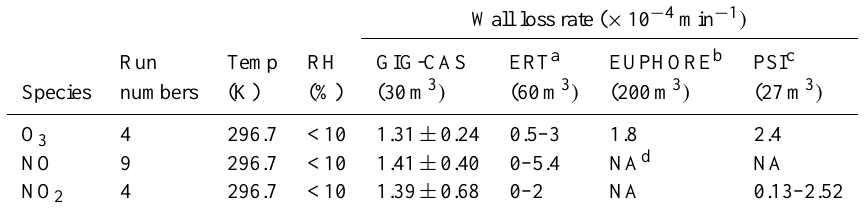
Table 2. Summary of wall loss rates of gas species in GIG-CAS chamber and comparison with other chamber facilities.